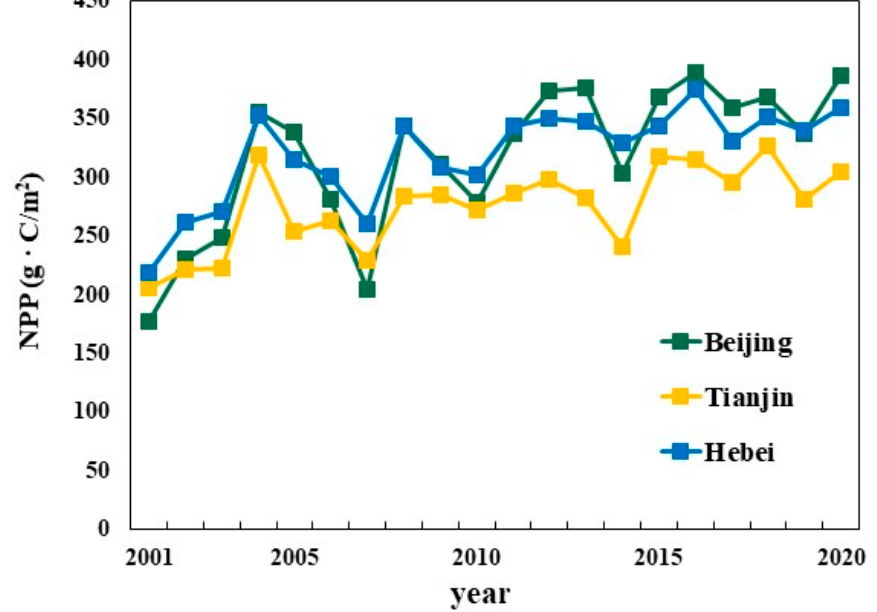
Figure 7. The annual value of NPP in Beijing, Tianjin, and Hebei.